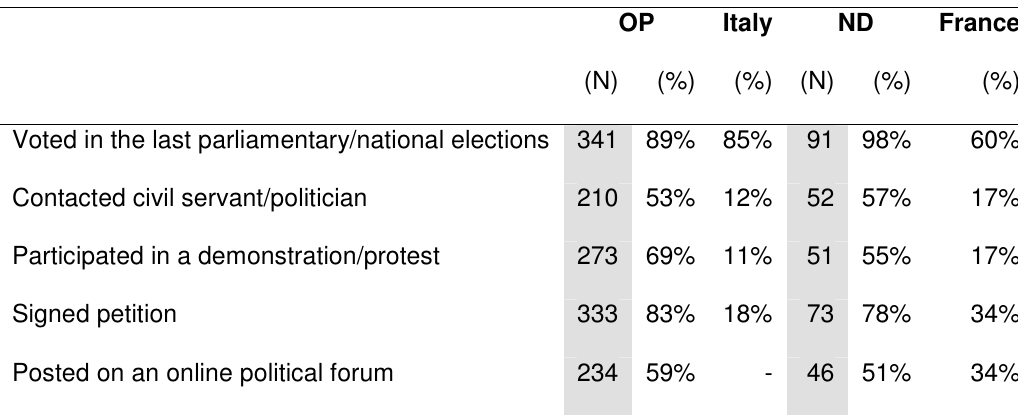
Table 5. Share of respondents and country populations involved in political activities (Authors’ surveys 2011; IDEA 2008 13 ; ESS1-2002; INSEE 2010 14 ) OP Italy ND France (N) (%) (%) (N) (%) (%) 341 89% 85% 91 98% 60% 210 53% 12% 52 57% 17% 273 69% 11% 51 55% 17% 333 83% 18% 73 78% 34% Posted on an online political forum 234 59% - 46 51%